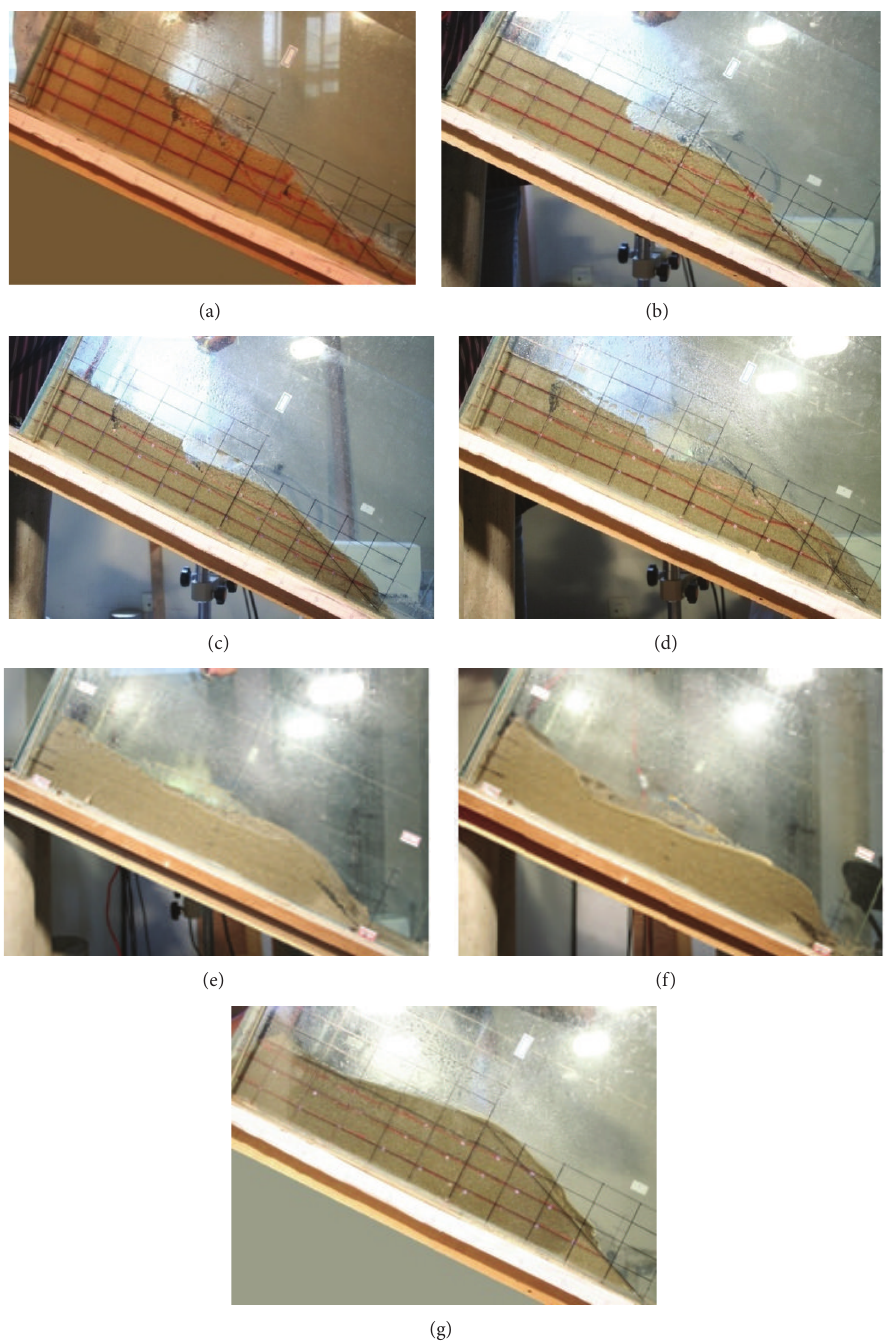
Figure 8: Failure of sand slopes with different fine particle contents: (a): medium sand, (b): 10% of fine sand, (c): 20% of fine sand, (d): 30% of fine sand, (e): 40% of fine sand, (f): 50% of fine sand, and (g): fine sand.